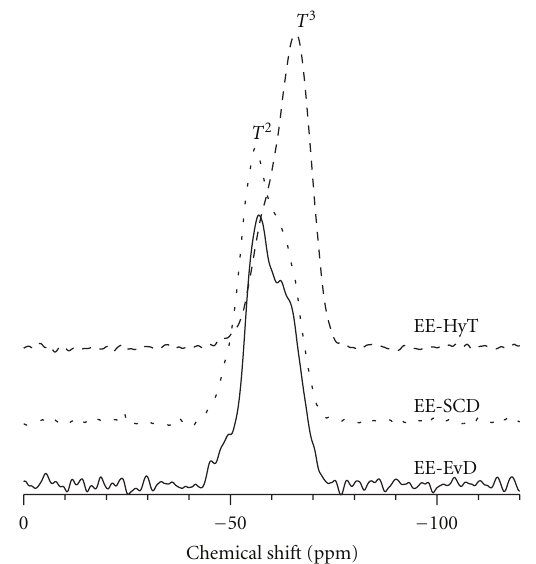
Figure 8: 29 Si CP/MAS NMR spectra of the EE-EvD, the EE-SCD and the EE-HyT